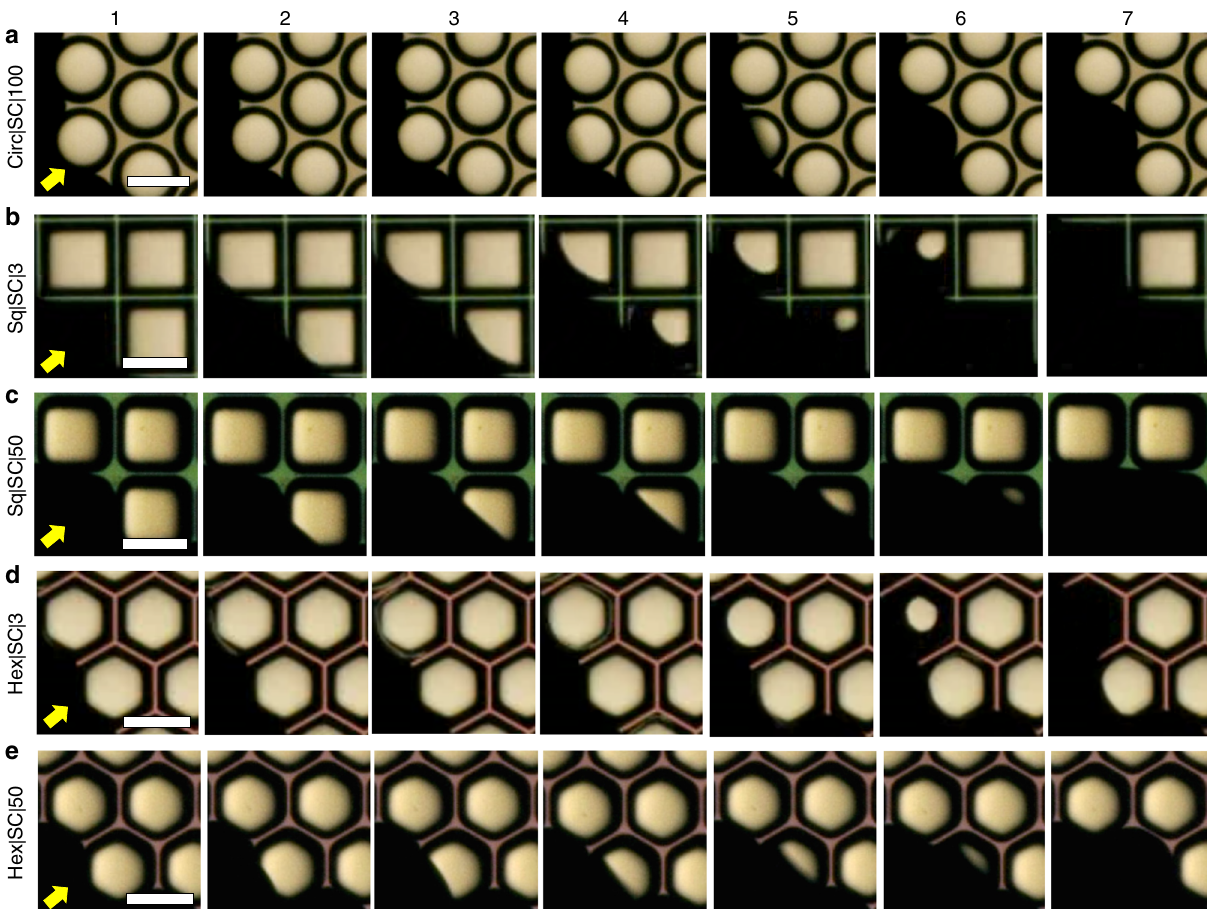
Fig. 2 Silica surfaces with simple cavities (SCs) immersed in hexadecane. Series of frames obtained by a high-speed camera at 1500 fps during imbibition of hexadecane in SCs of a circular ( D = 200 µ m), b , c square, and d , e hexagonal geometries of b , d sharp ( r = 3 µ m) and c , e rounded ( r = 50 µ m) corners (see Supplementary Movies 1 – 5). Yellow arrows indicate the direction of the advancing liquid at the onset of immersion. Imbibition was faster in cavities with sharper corners as Sq|3 > Hex|3 > Sq| 50 > Hex|50. (Scale bars: 200 µ